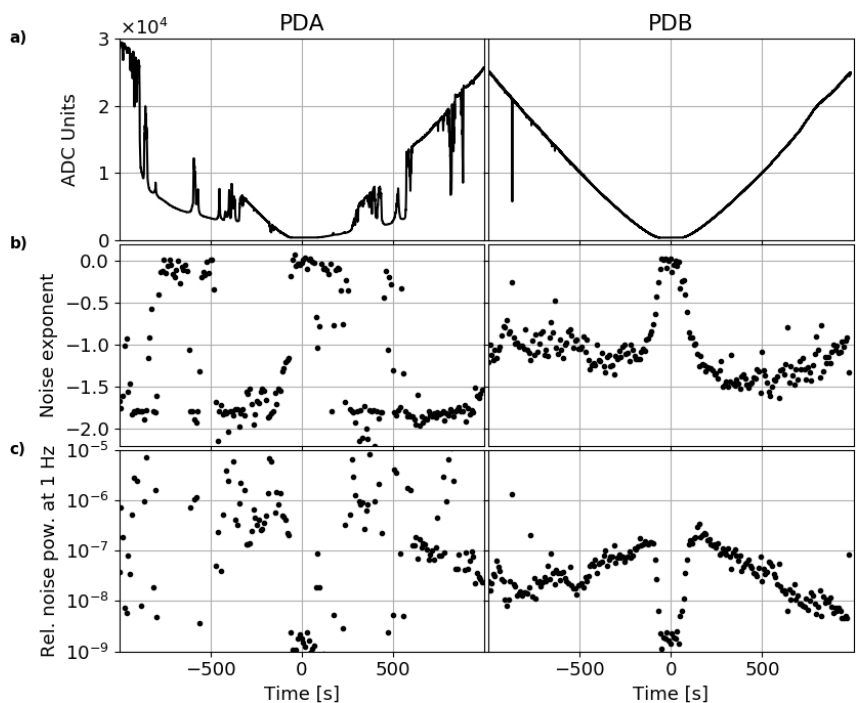
Figure 3: Spectral properties of the measured time series. a) The time series for each photodiode. Each signal is normalized in chunks of N=2048 points, and the noise exponent of the power spectrum for each of these chunks is plotted in b). The exponents are calculated by performing linear fits of each chunk in log-log scale. The value of this fit at 1 Hz is showed in c), giving the noise at that frequency as a function of